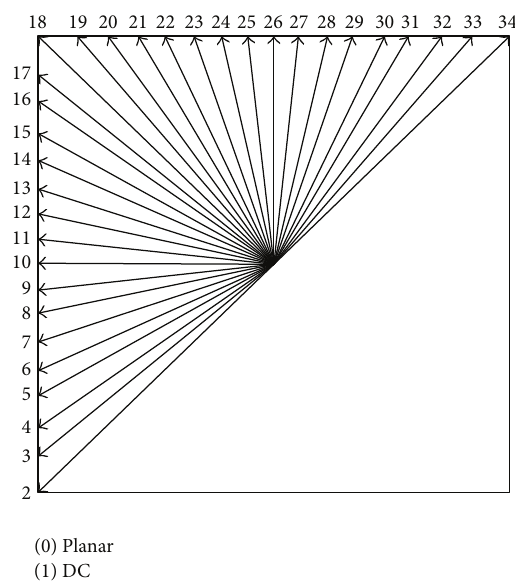
Figure 1: Intraprediction modes and their directional orientations in